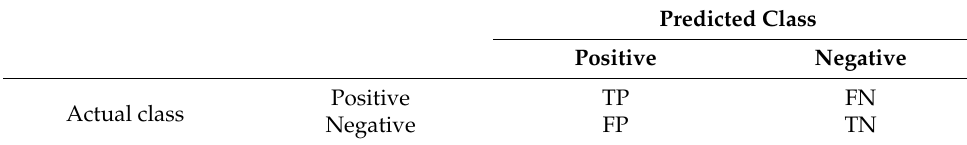
Table 3. Confusion matrix (a) and accuracy formula (b).